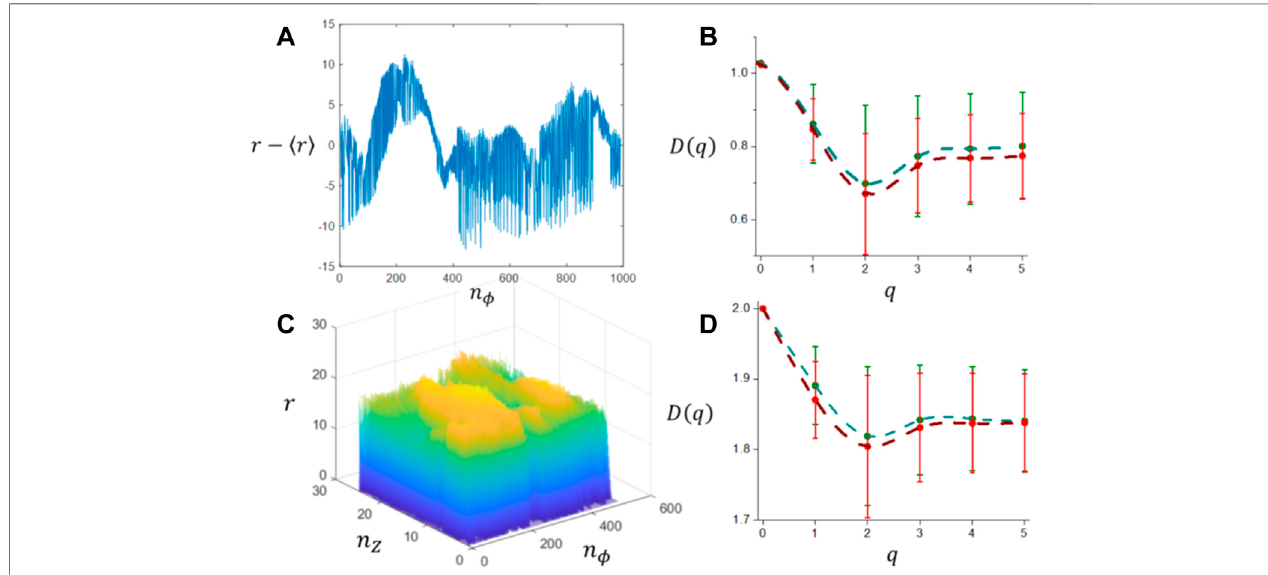
FIGURE 13 | Multifractal and detrended fl uctuation analysis results. (A) Typical ordered series extracted from an slice; (B) Generalized fractal dimensions associated to the ordered series obtained by multifractal analysis using the partition function Z ; (C) Two dimensional landscape for r as a function of n Z and n ϕ , and (D) Generalized fractal dimensions obtained by 2D Detrended Fluctuation Analysis. In (B,D) , meningiomas and acoustic schwannomas are represented in green and gliomas in red.